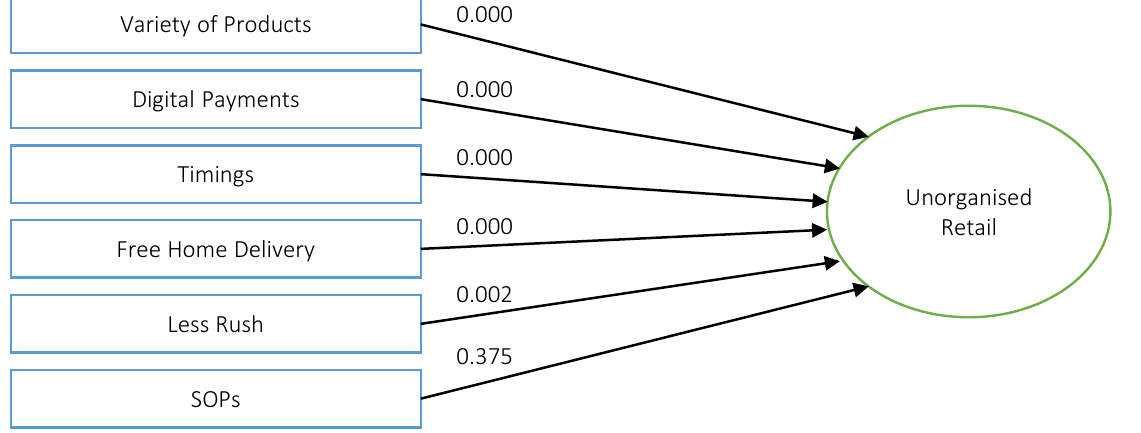
Figure 1. Regression